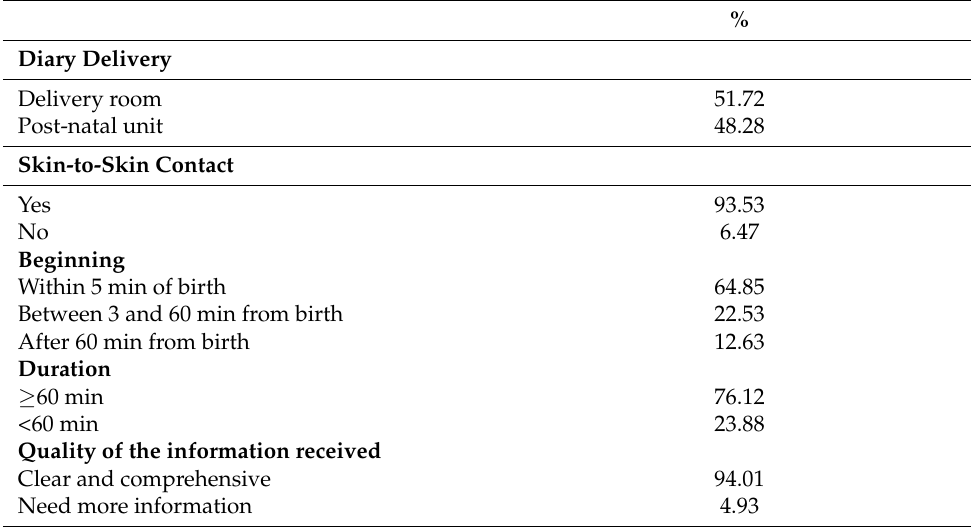
Table 3. Data obtained from the 269 Diaries